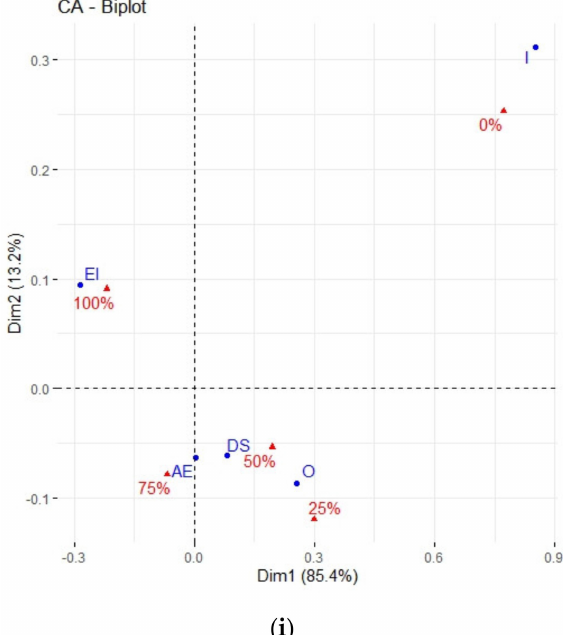
Figure A1. Correspondence maps showing the links between the 5 types of energy consumers and their declared degree of usefulness of selected types of incentives: ( a ) training or another form of organized education; ( b ) regular updates on energy consumption provided by an energy supplier (website, phone, direct contact, etc.); ( c ) initiatives within local communities aimed at energy saving; ( d ) promotional and informational material from energy companies (leaflets, brochures, websites); ( e ) information obtained from the Internet and social media; ( f ) obtaining non-repayable funding for investments related to energy saving or RES; ( g ) energy self-sufficiency as a result of being an energy producer; ( h ) social influence creating the need for pro-environmental behaviour incorporated as an internal need for environmental protection; ( i ) care about own and family’s health translating into care for the quality of the